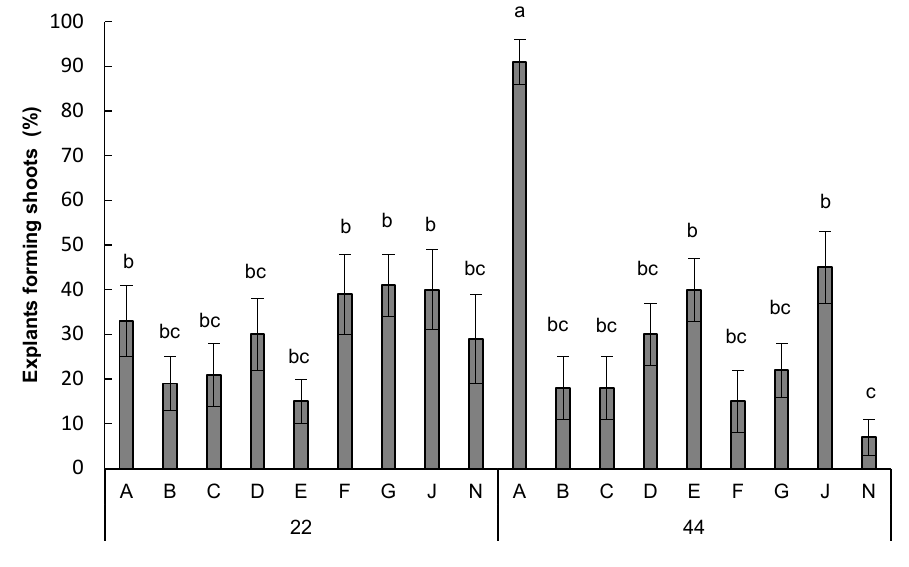
Figure 3. Explants forming shoots (%) shown in buds of different genotypes of Pinus radiata D. Don cultured in Quoirin and Lepoivre (LP) medium [27], modified according to Aitken-Christie et al. [28], supplemented with 6-benzyladenine (BA at 22 and 44 µ M). Data are presented as mean values ± S.E. Different letters indicate significant differences by Tukey’s post hoc test ( p <